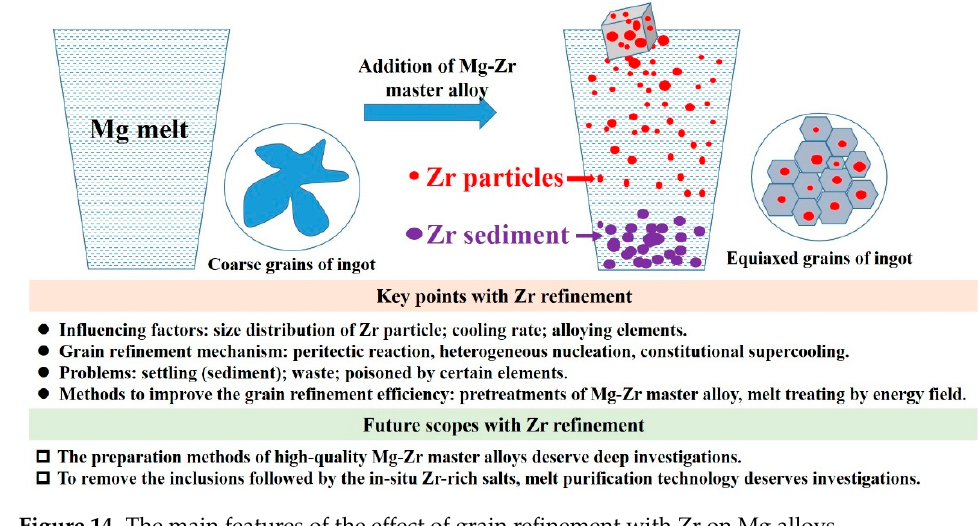
Figure 14. The main features of the effect of grain refinement with Zr on Mg alloys.